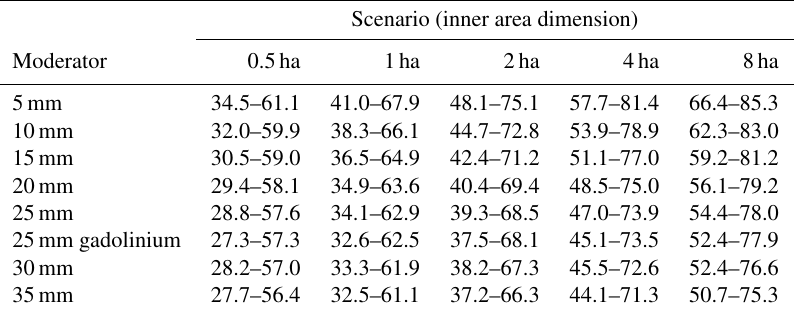
Table 2. Minimum and maximum percentage of detected (albedo plus non-albedo) neutrons originating within the inner area depending on SM conditions with different moderators and different scenarios.